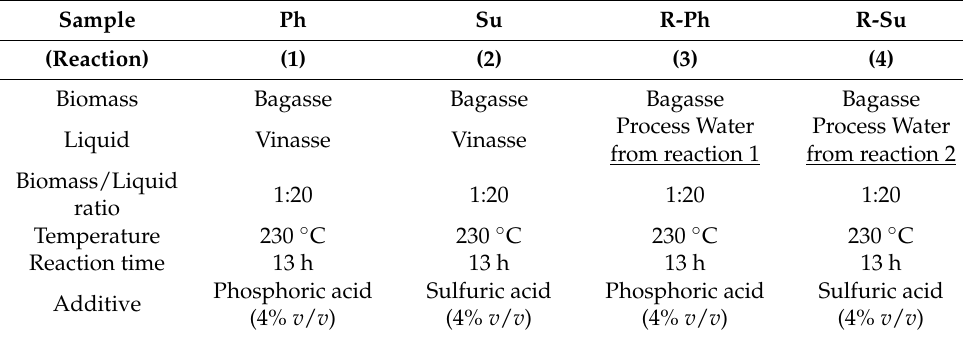
Table 2. Parameters and starting materials of hydrothermal carbonization